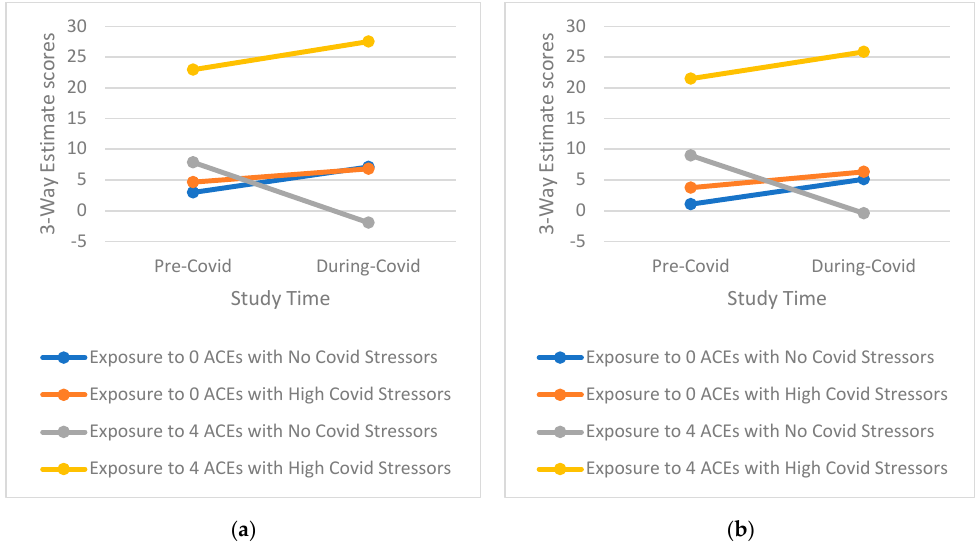
Int. J. Environ. Res. Public Health 2022 , 19 , x FOR PEER REVIEW 8 of 18 Figure 1. ( a ) Interaction of greater exposure to ACEs and high levels of Loneliness on Changes in Depressive Symptomatology among Young Adults from Before to During the COVID-19 Pandemic; ( b ) Interaction of greater exposure to ACEs and high levels of Frustration on Changes in Depressive Symptomatology among Young Adults from Before to During the COVID-19 Pandemic.